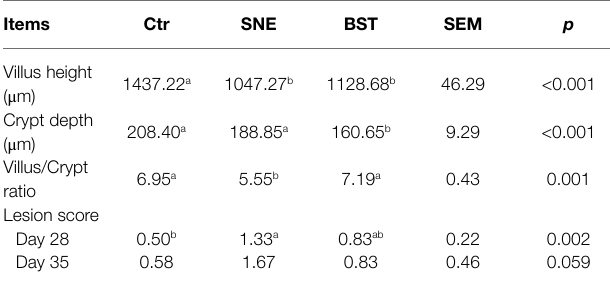
TABLE 4 | The jejunum histomorphology of broilers infected with Clostridium perfringens .